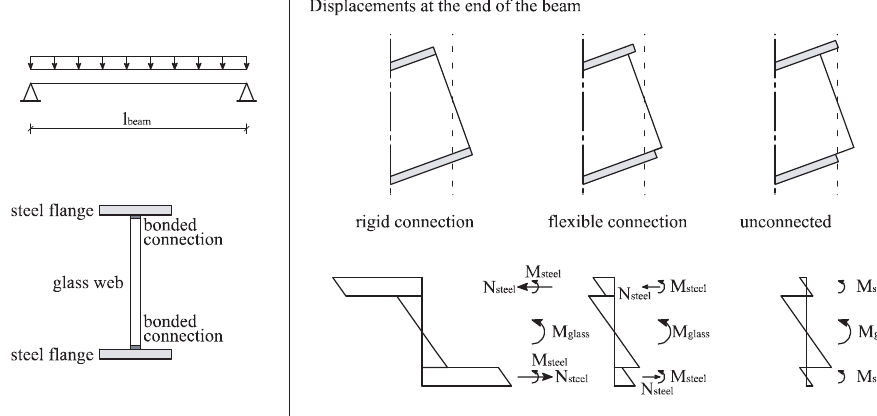
Figure 2: Behaviour depending on joint